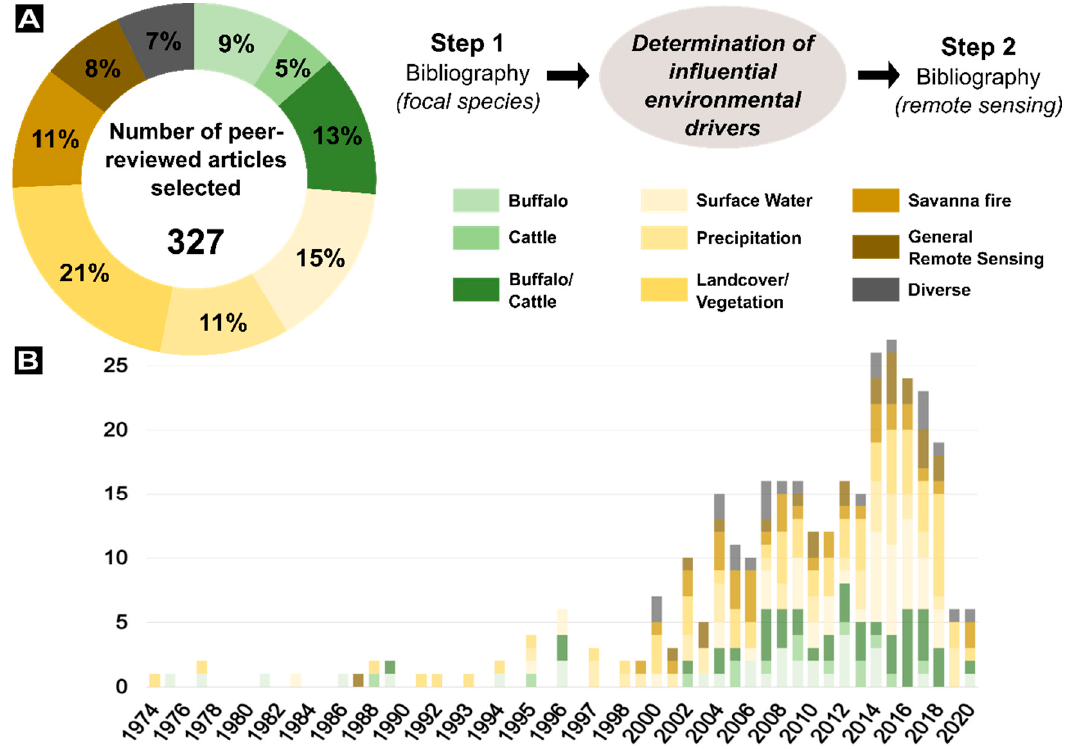
Figure 2. Statistics and chronology of the article bibliography by topic category. ( A ) The ring diagram represents the percentage of each category in relation to the total number of reviewed articles. ( B ) The horizontal axis of the histogram corresponds to the published year of the selected articles. The vertical axis corresponds to the number of published articles according to their respective categories.